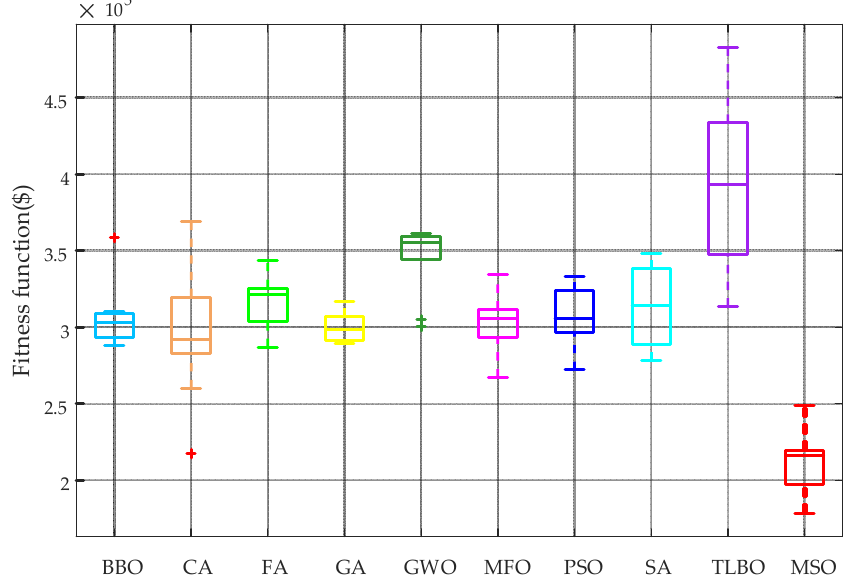
Figure 11. Box and whisker plots of total operating costs obtained by ten algorithms in 10 runs.